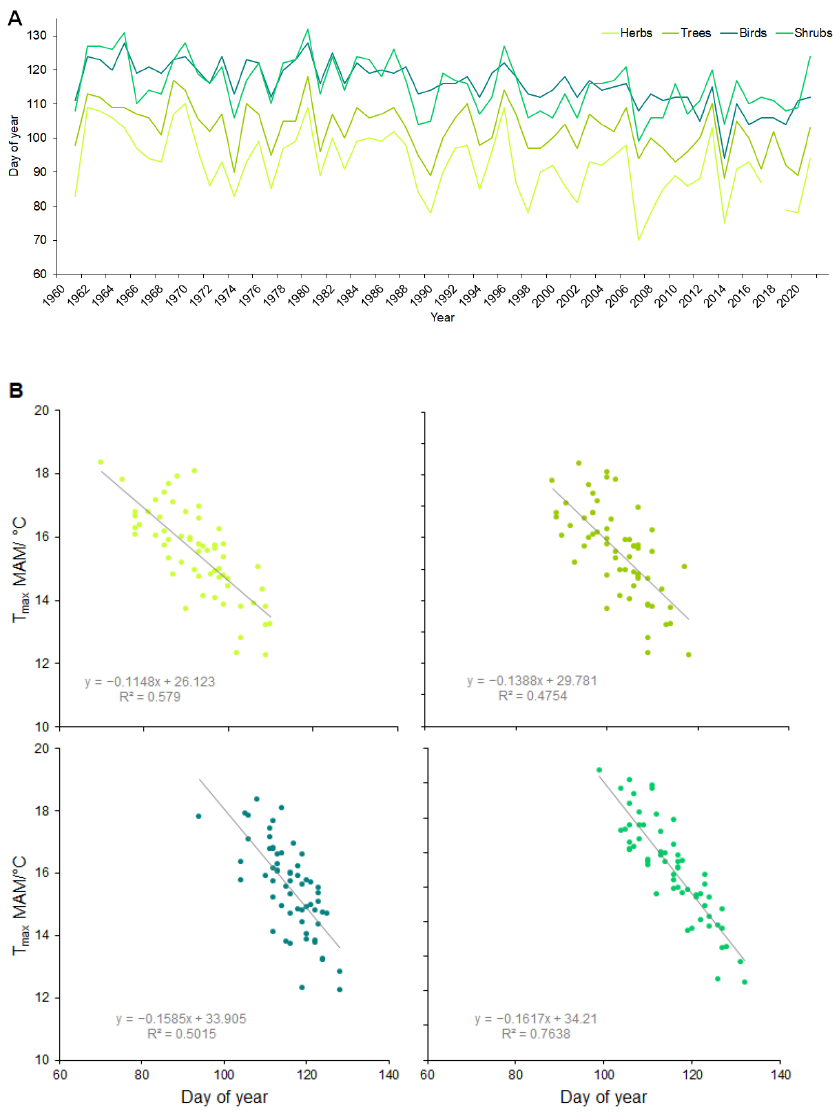
Figure 3. ( A ) Average terms of phenological phases for herbs, shrubs, trees, and birds for the period of 1961–2021. ( B ) Relationship between daily air maximum temperature in MAM (March, April, May) and the terms of phenophases for average values of herbs, shrubs, trees, and birds.